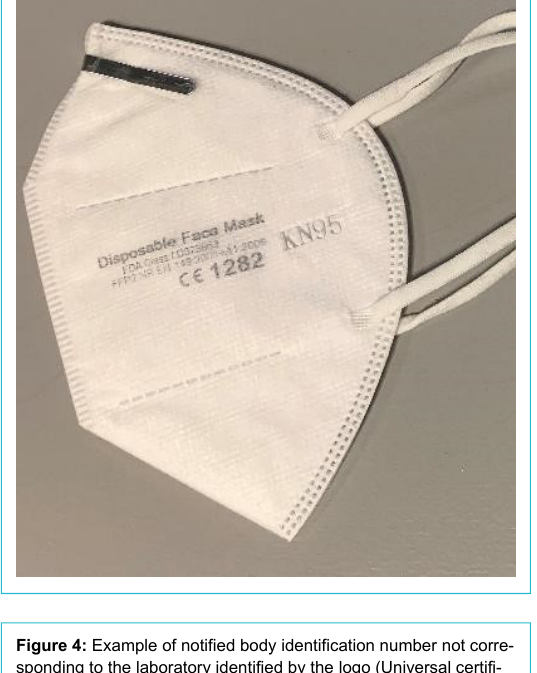
Figure 3: Example of an identification number written on a FFP respirator designating a notified body not accredited to certify the